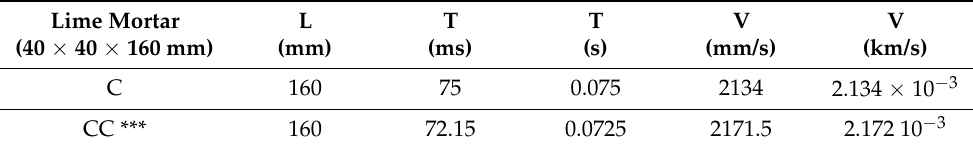
Table 3. Direct ultrasonic testing of unconsolidated lime mortar specimens (mean values). Lime Mortar